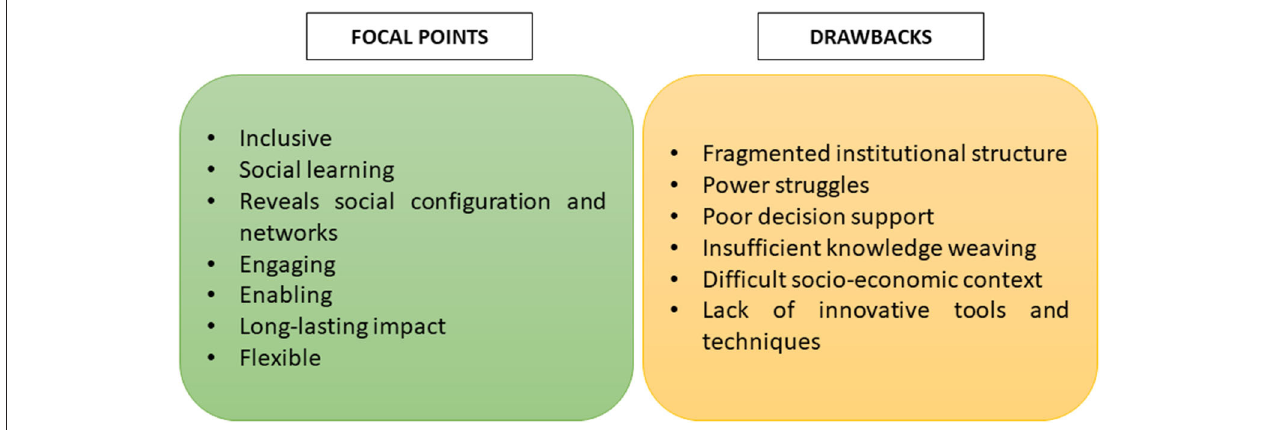
FIGURE 1 | Summary of the focal points and drawbacks of a co-design process to address NBS for inclusive urban planning.